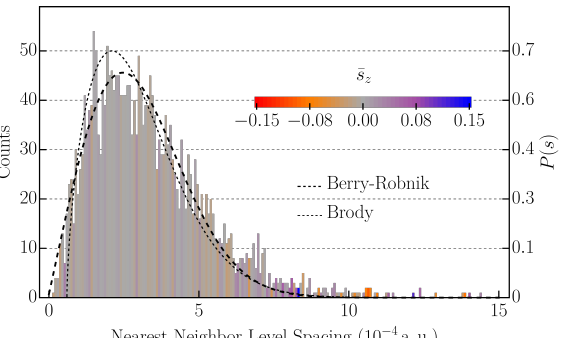
Figure 2. Nearest neighbor level spacing histogram for a square with a size of 100 × 100a.u. with periodic boundary conditions in the x -direction, α = 20meVÅ, B = 1T, with ten impurities with a strength of 0.18a.u. and FWHM = 8a.u. In total, three-thousand and six energies are distributed into 200 bins of width 7.2 × 10 − 6 a.u. The mixing parameter q BR (Equation (4)) is equal to 0.134, and the Brody parameter (Equation (5)) q B equals 0.637. The color code shows the mean of all s z values of all states belonging to the bin. The (mean) spin-polarization is higher when the states have small or very large energy